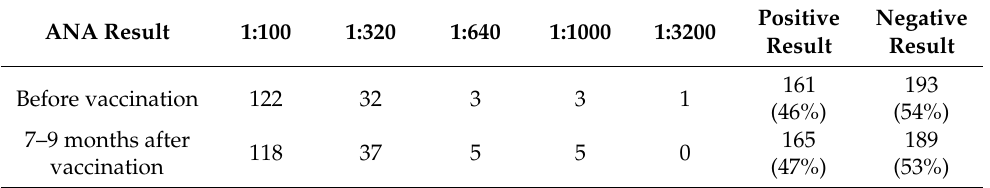
Table 3. ANA assays including titres in the study group before and after COVID-19